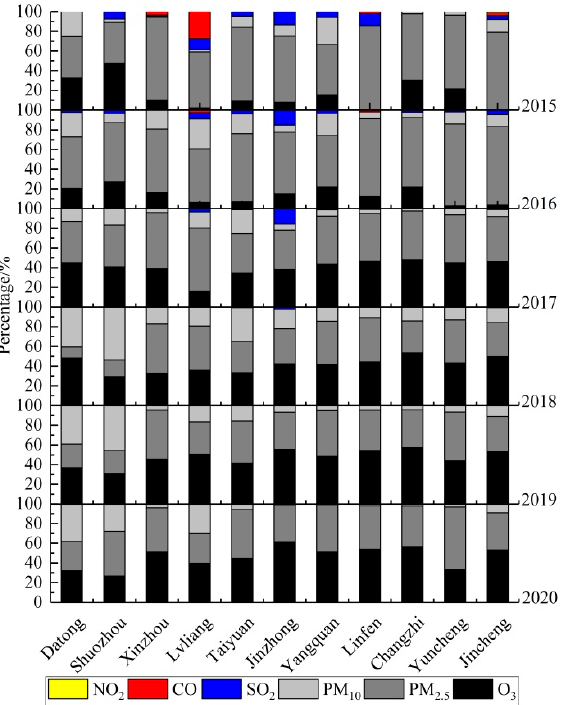
Figure 2. The variation in the proportion of nonattainment days of six primary pollutants in 11 cities in Shanxi Province from 2015 to 2020.